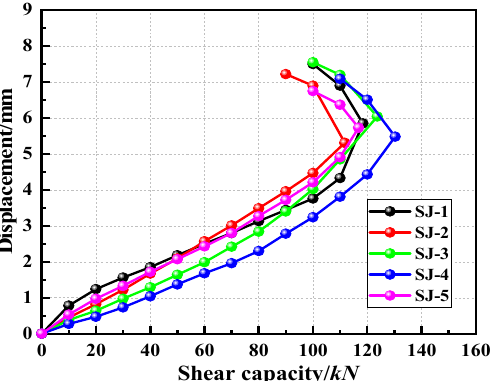
Figure 13. Graphs of the shear capacity of the wheel under central pole conditions. Table 3. Ultimate shear capacity under three conditions.